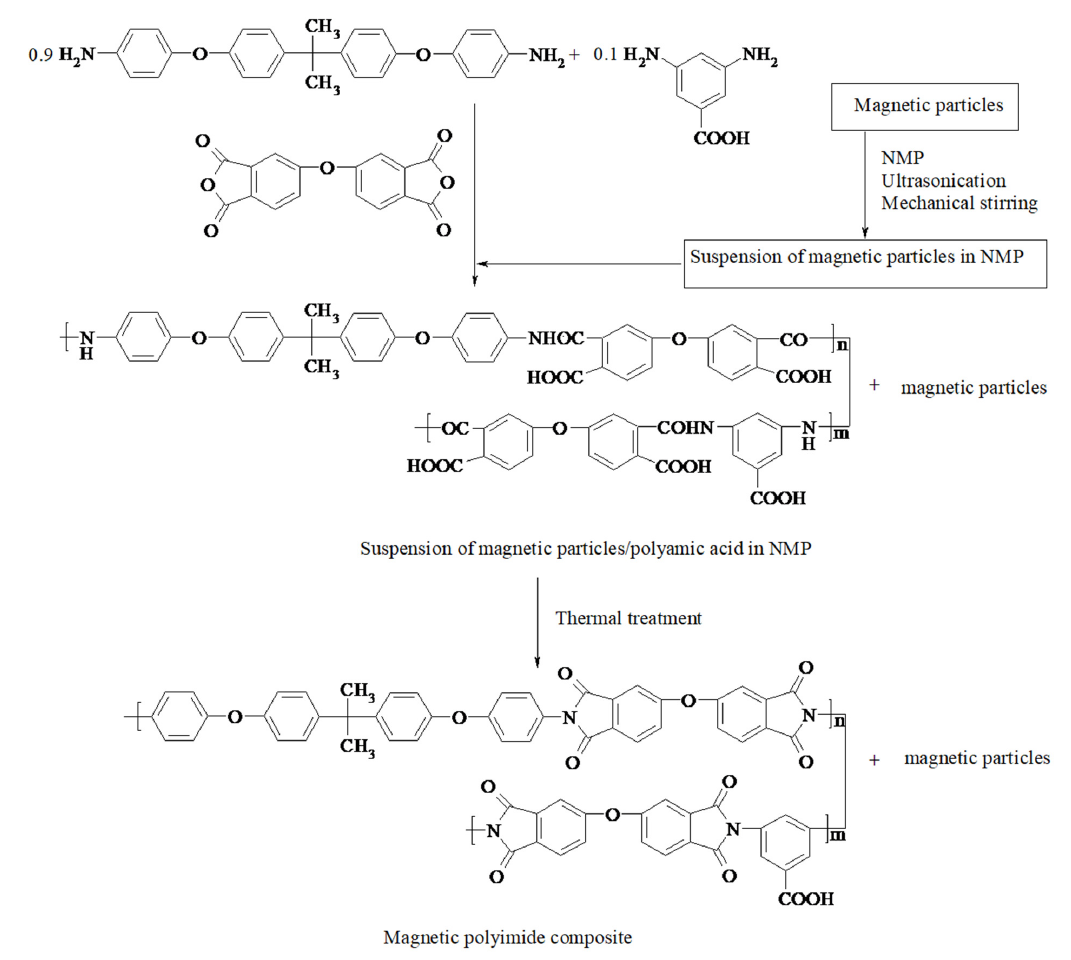
Figure 1. Preparation of magnetic polyimide composites. Table 2. Type and concentration of ferrite particles for each composite sample.